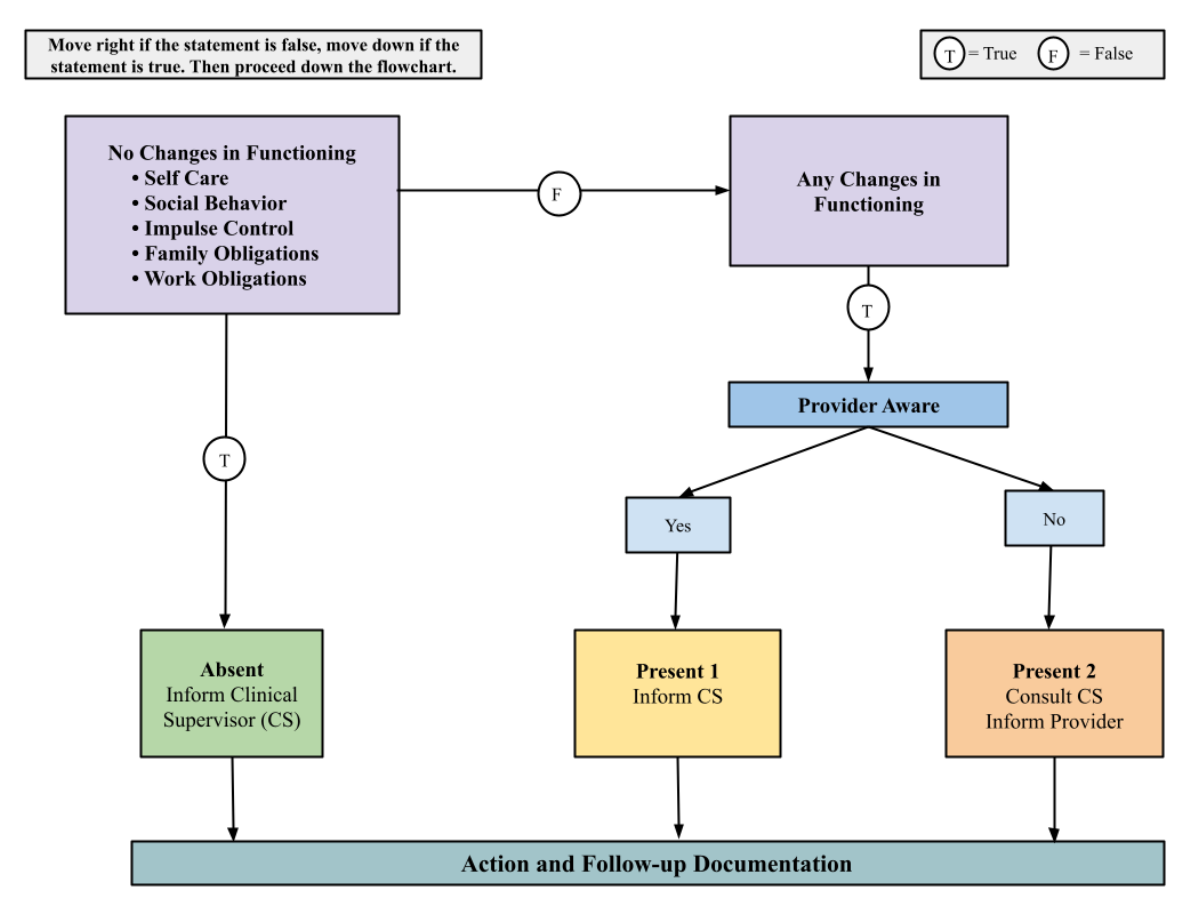
Figure 4. Functional evaluation protocol flowsheet. CS: clinical